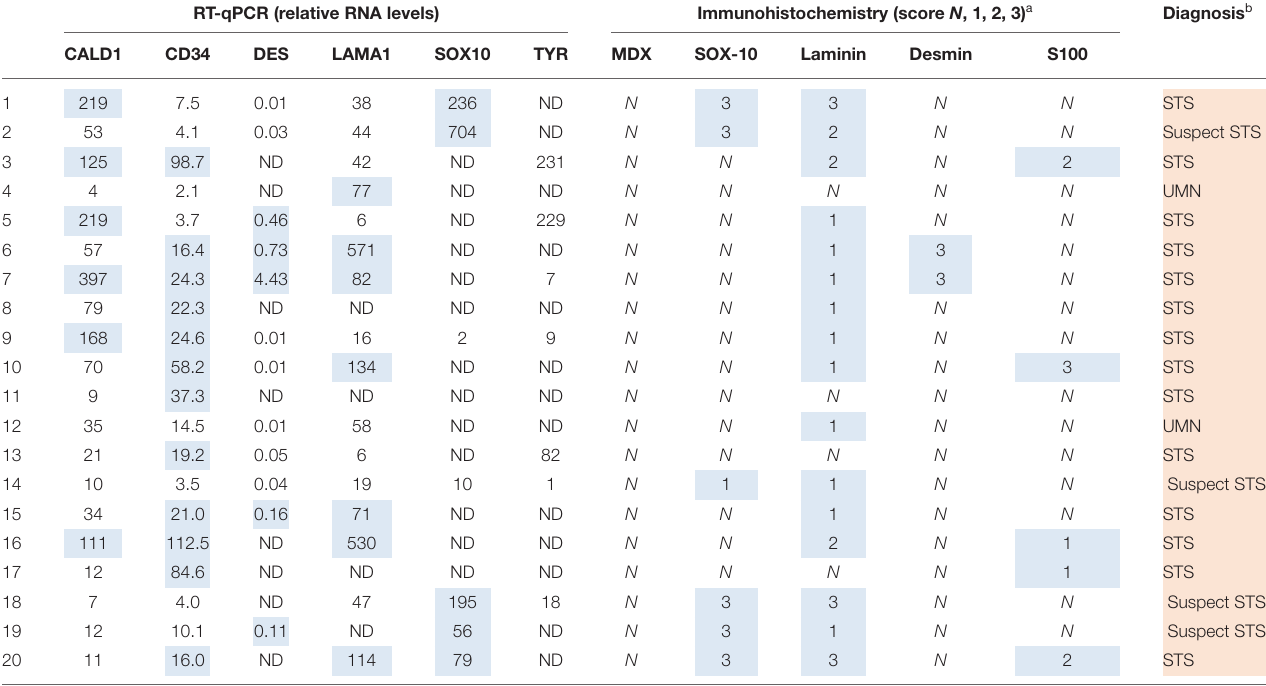
TABLE 6 | Relative RNA levels and immunoreactivity of oral spindle cell tumors. RT-qPCR (relative RNA